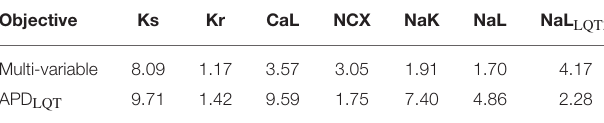
TABLE 1 | Scaling factors for optimized